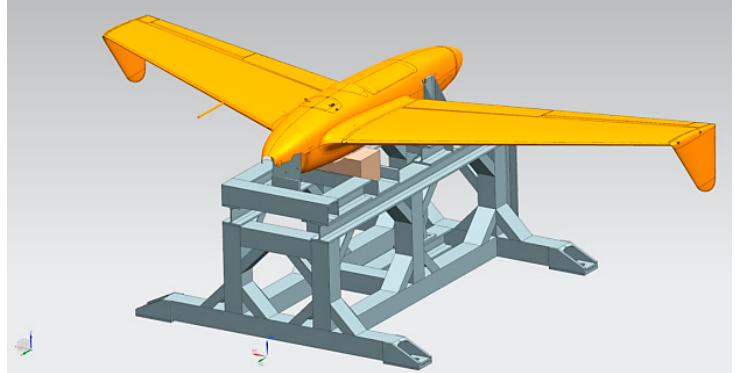
Figure 11. Test bed for static loading ground test configured for aerodynamical loads representation.